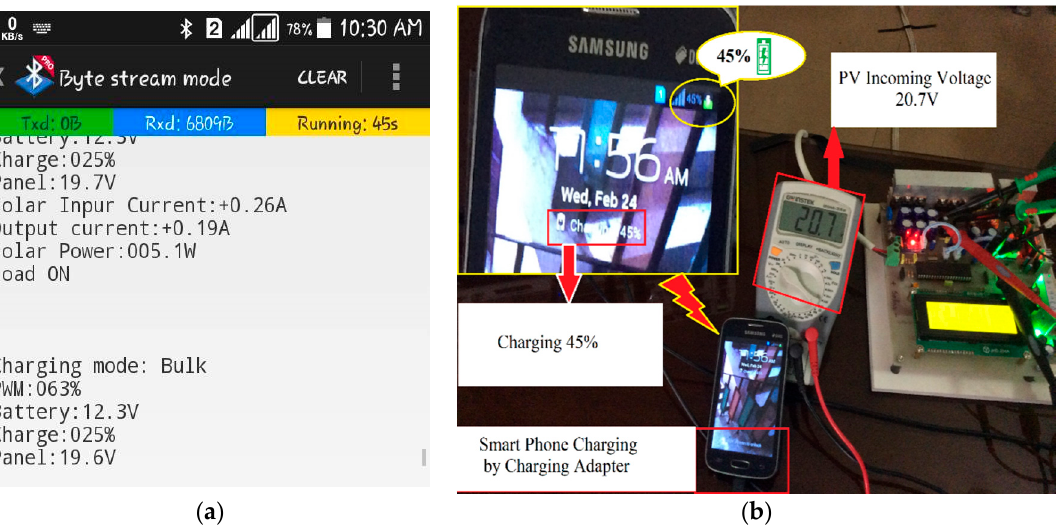
Figure 13. ( a ) System monitoring by smartphone through IoT, ( b ) external device charging